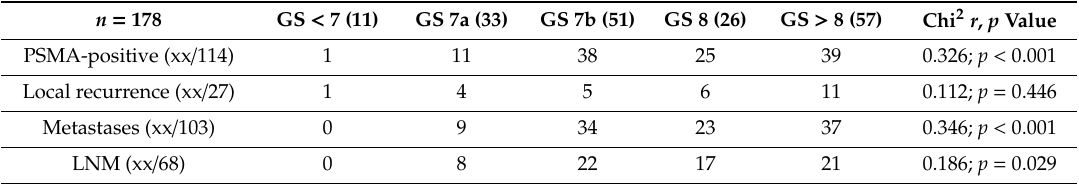
Table 4. Gleason score in relation to [ 68 Ga]Ga-PSMA-11 PET / CT LPR